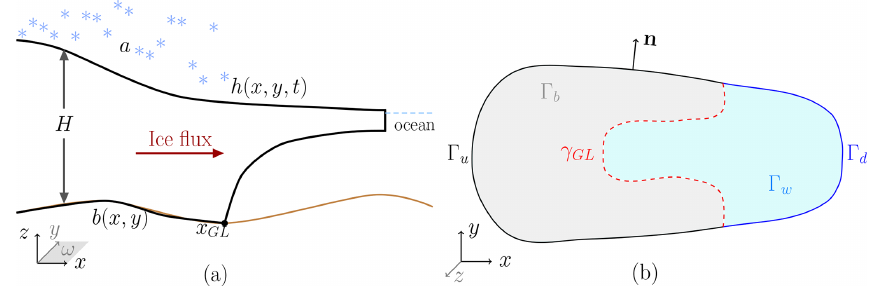
Figure 1. A schematic view of an ice sheet in the (a) x – z plane and (b) x – y